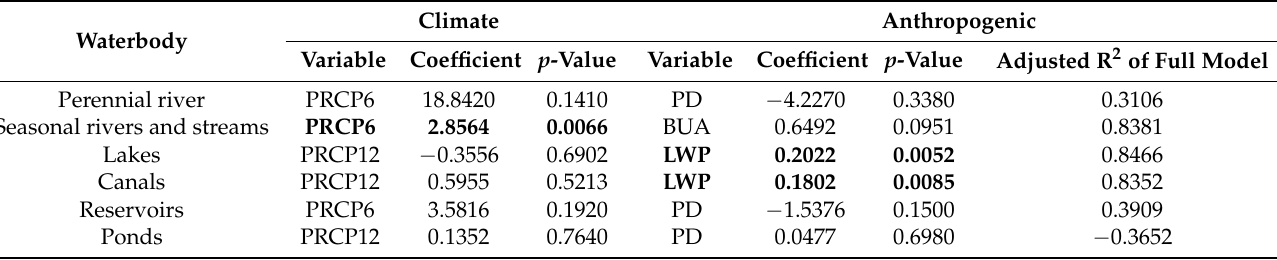
Table 5. Linear regression for the total surface area of each type of waterbody (waterbody~ climatic variables + anthropogenic variables). Significant variables are highlighted with bold text. PRCP6 represents average monthly precipitation in the 6 months prior to satellite image capture; PRCP12 represents average monthly precipitation in the 12 months prior to satellite image capture; PD represents population density; BUA represents built-up area; LWP represents length of water pipeline.